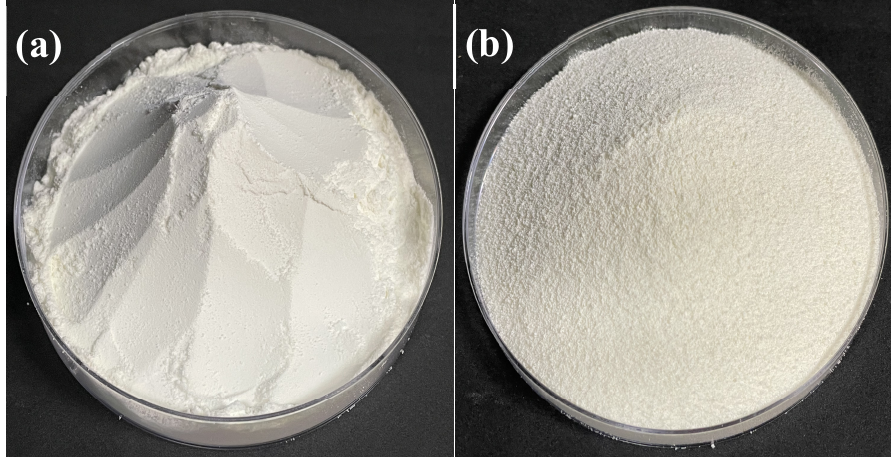
Figure 1. Typical sample appearance of ( a ) raw and ( b ) agglomerated MPIPs prepared by FBAP.